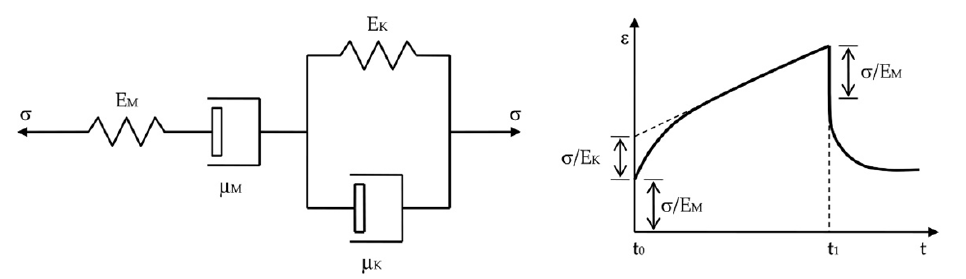
Figure 8. Burgers visco-plastic rheological model and related time-dependent behavior in relation to the considered